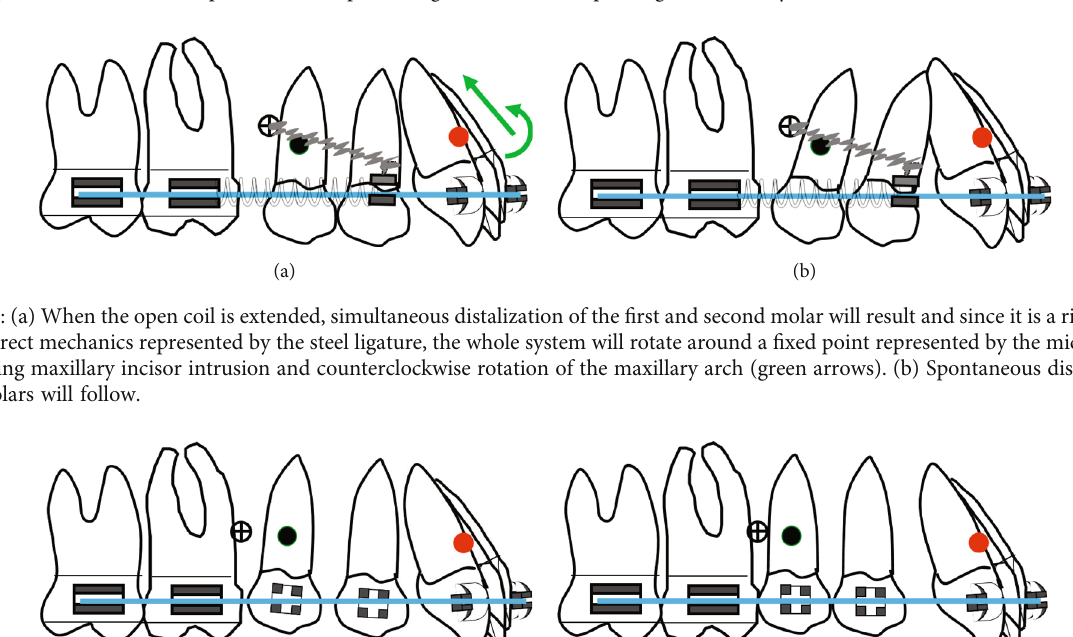
Figure 2: (a) An open coil is activated via a steel ligature from the microimplant to a sliding hook. Care should be taken to select the length of the coil equal to the distance distal canine bracket-mesial fi rst molar tube so that in case of failure of the microimplant no anterior anchorage loss will occur. (b) Open coil is compressed against the molars pushing them distally.